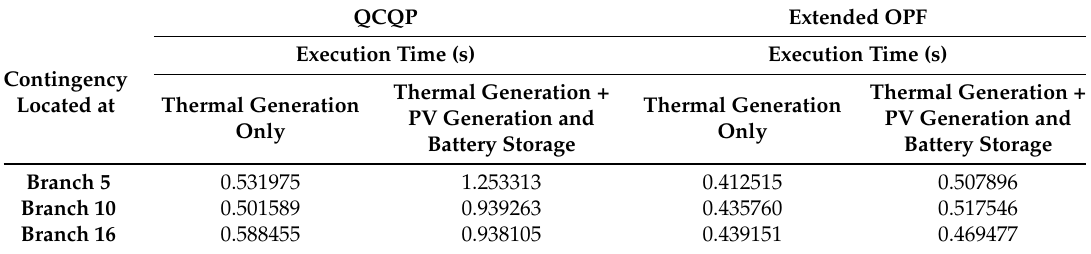
Table 2. Execution times obtained after implementation of QCQP and extended OPF